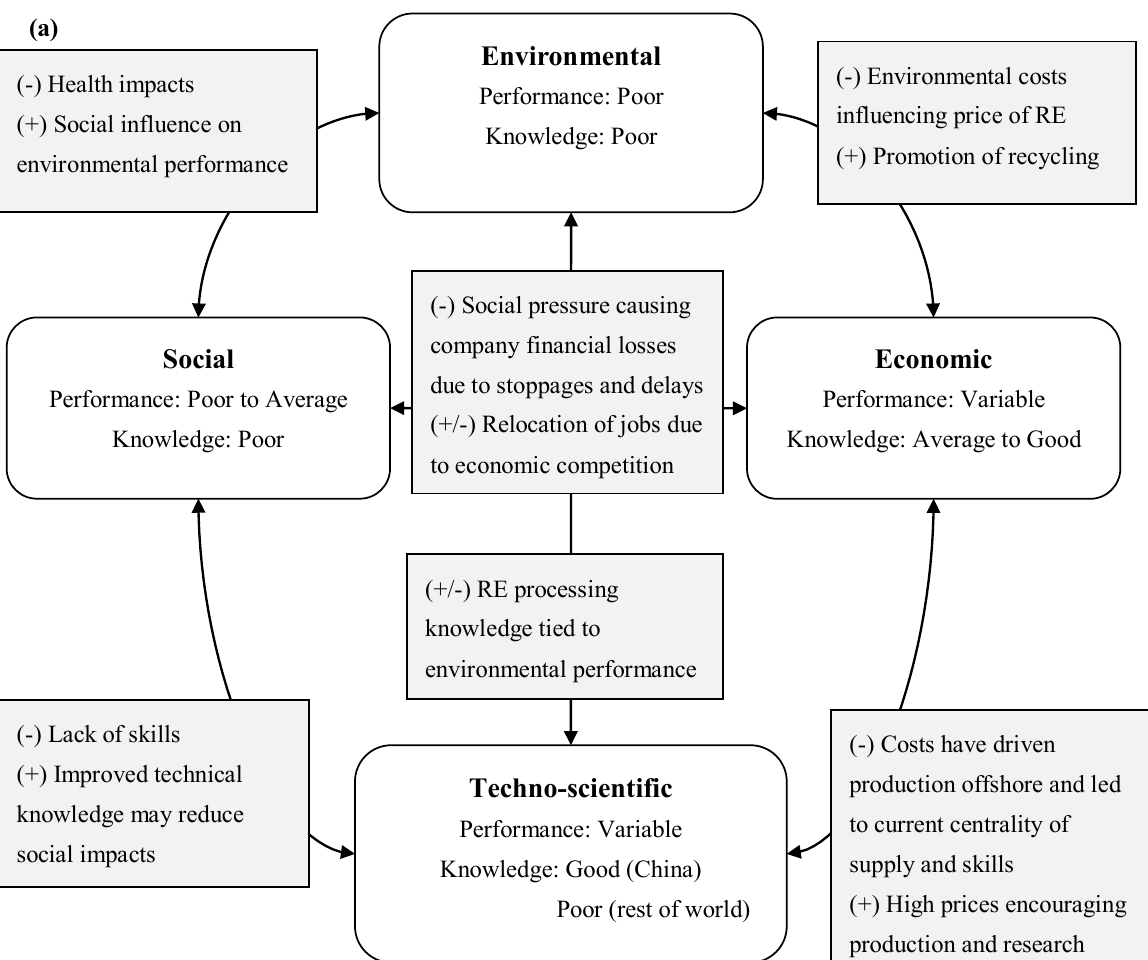
Figure 2. Sustainability aspects, connections and level of development with regards to rare earths: ( a ) Primary production and ( b ) End